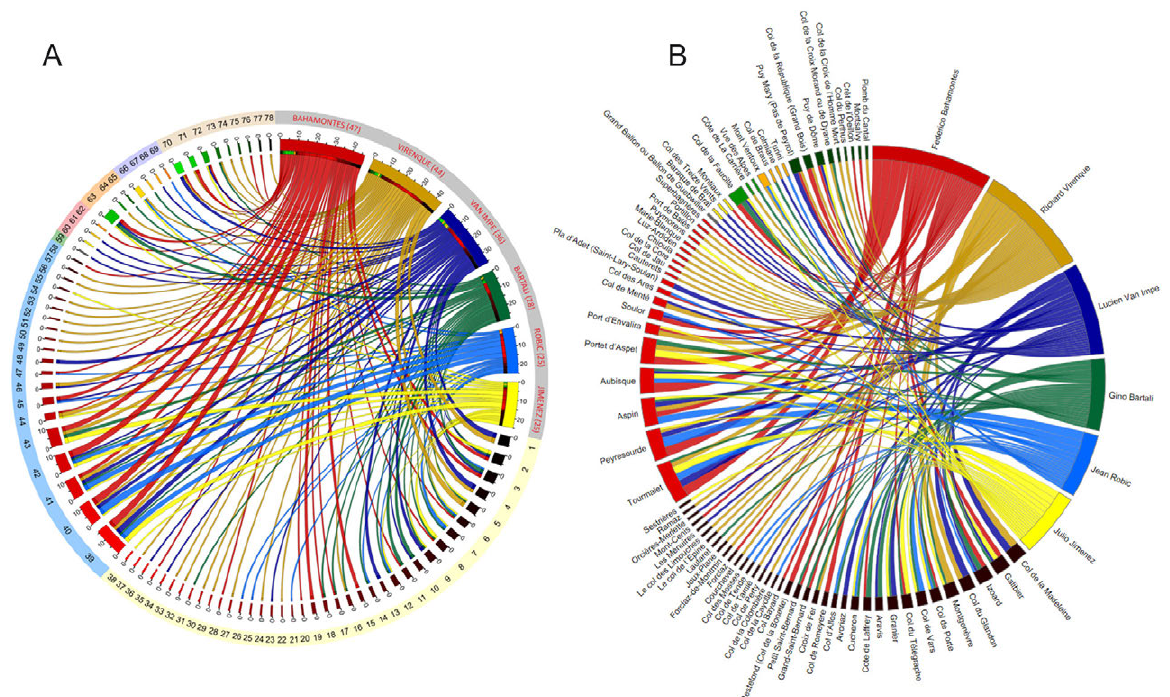
Fig. 2. An example of data circular visualization using a chord diagram (In this picture places of the triumphs of the most successful climbers in the Tour de France history are